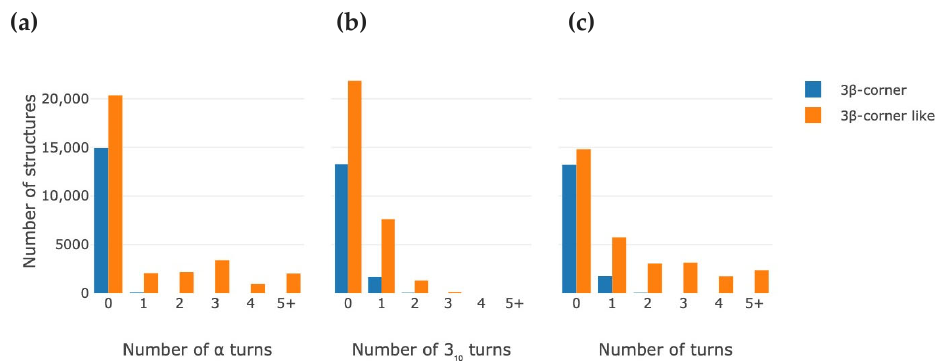
Figure 4. Distribution histograms of the number of found motifs depending on the amount of helix coils in them. ( a , b ) Histograms show distribution based on separate α -helix turns and 310-helix turns respectively. ( c ) Histogram shows distribution of motifs depending on total amounts of helix turns in motif.